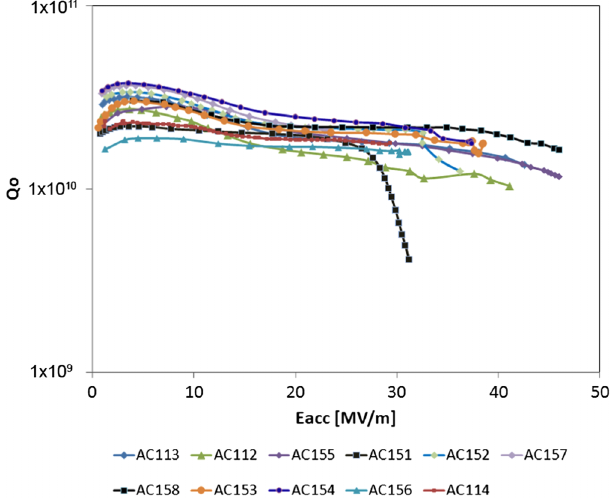
FIG. 13. Final Q 0 ð E acc Þ performance of the LG cavities AC112–AC114, AC151–AC158 at 2 K after EP.